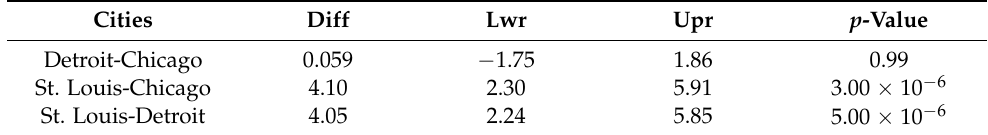
Table 2. Results of a Tukey HSD post hoc analysis reveal significant differences in the average temperature in 2016 between St. Louis and Chicago and between St. Louis and Detroit.